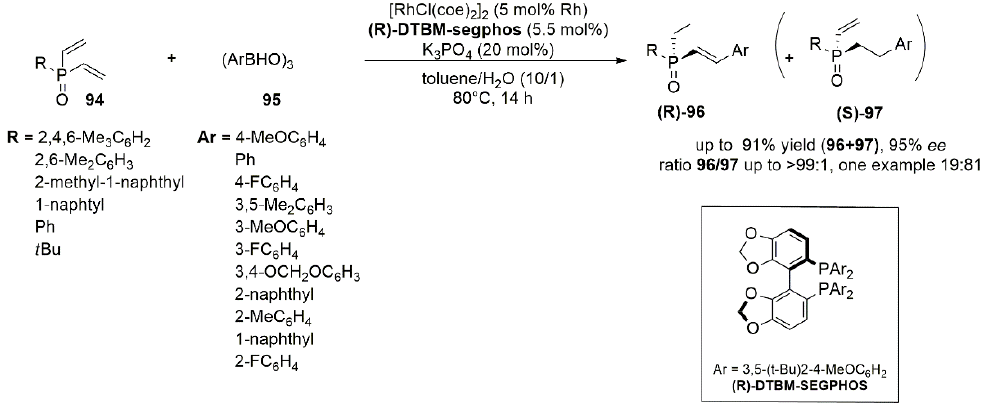
Figure 40. Rhodium-catalyzed hydroarylation of 2-aryl chromenes: Deuterium-labeling experiment and proposed mechanism. After optimization of reaction conditions and screening of several biphosphines lig- ands, which showed that (R)-Difluorphos gave the best results, the authors examined the scope with respect of variously substituted flavenes and aryl boronic acids. Good yields and excellent ee were obtained in most cases, proving that the substituents on both the benzopyran and C2-phenyl ring have limited effect on the enantioselectivity and most of the aryl boronic acids provides the desired product with good results. Further application of this strategy was developed for dynamic resolution of chromene acetals providing the